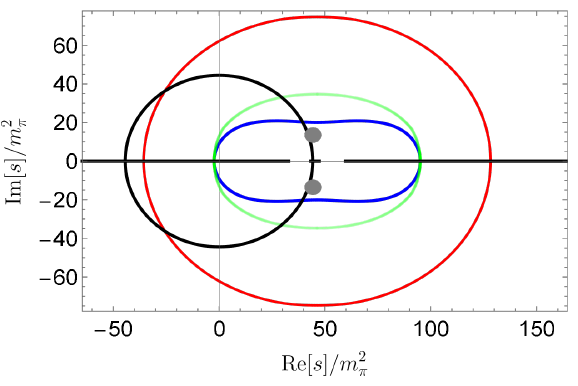
Figure 2 . Validity domain of the fixed- b RS representation ( a = 0 ). The blue and green lines correspond to the boundaries in the s 0 and t 0 integrals associated with ρ st , respectively. The red line corresponds to the boundaries in the s 0 integral associated with ρ su